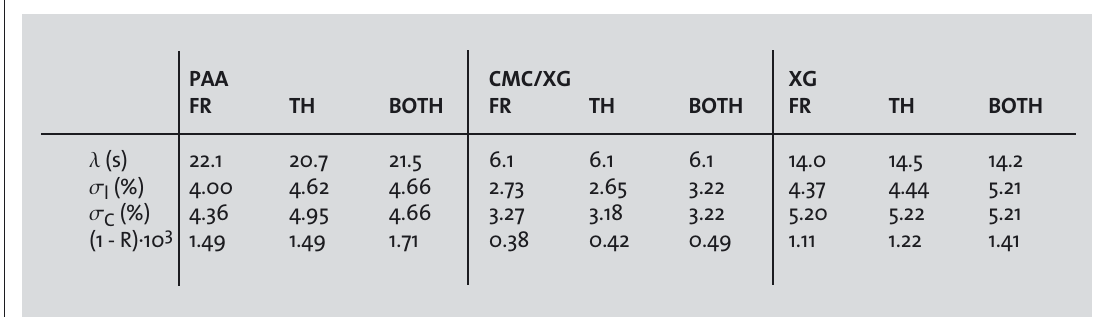
Table 2: Characteristic relaxation times based on Maxwell model fit and corresponding statistical